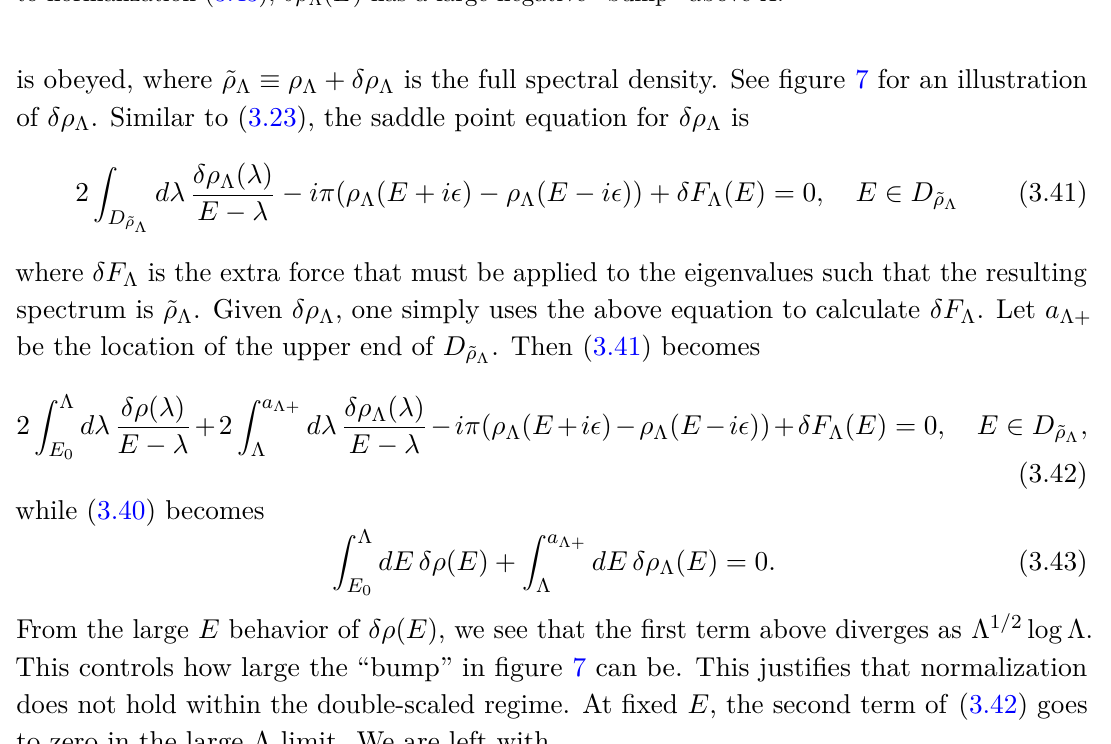
Figure 7. The blue curve is spectral density ρ Λ ( E ) that matches with ρ JT ( E ) for E < Λ ; the yellow curve is full spectral density ˜ ρ Λ ( E ) with E 0 < 0 ; the red curve is the difference δρ Λ ( E ) . Due to normalization (3.43), δρ Λ ( E ) has a large negative “bump” above Λ